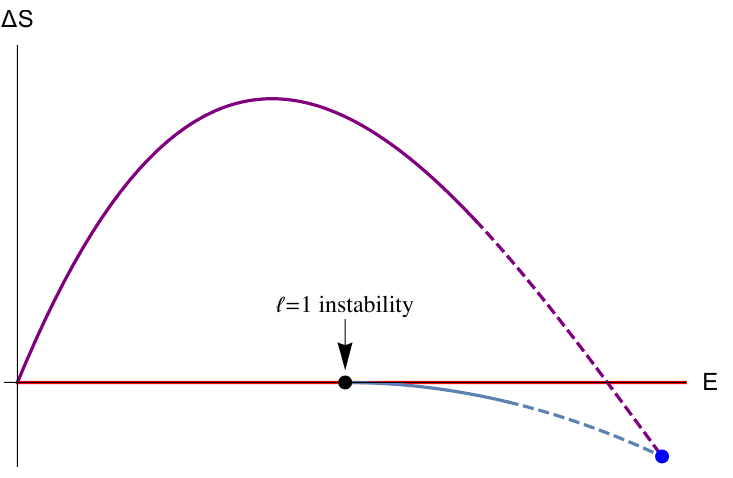
Figure 7 . Change in entropy vs. energy plot for small black hole solutions in d = 5, based on (cid:12)gure 3 of ref. [10]. The horizontal red line is the homogeneous Schwarzschild solution. The black dot is the onset of the ‘ = 1 instability. The solid blue line emanating from the ‘ = 1 instability indicates numerically constructed spot-like solutions with S 3 (cid:2) S 5 topology. The solid purple line indicates numerically constructed spot-like solutions with S 8 topology. The dashed lines are